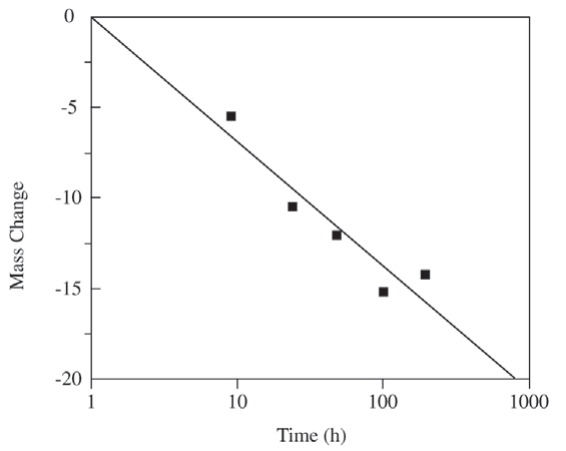
Figure 2. Mass change of Si 90